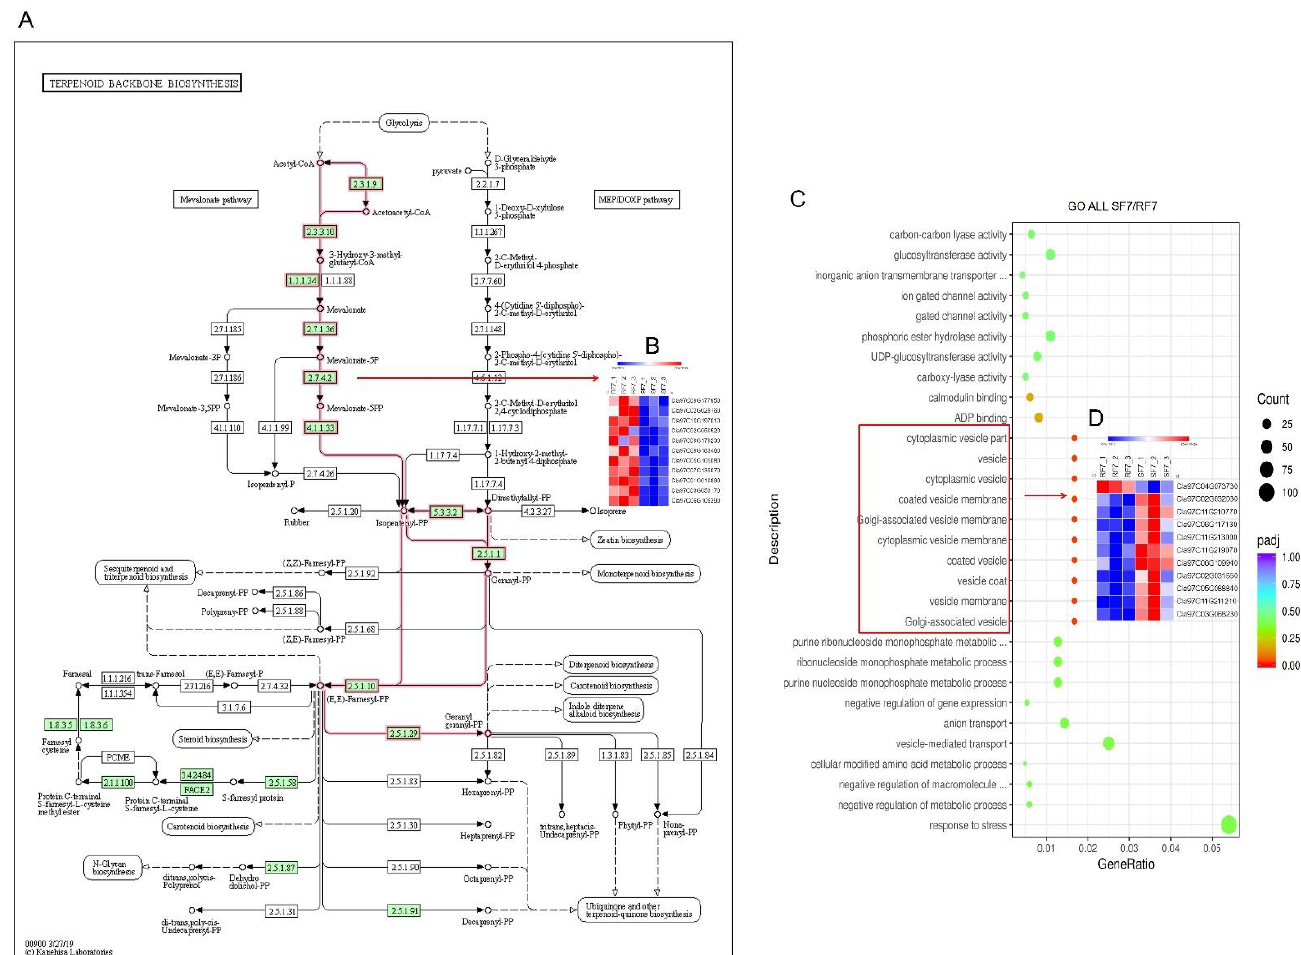
Figure 6. Function enrichment analysis of differential watermelon varieties: ( A ) Different expressed genes in Terpenoid backbone biosynthesis pathways; ( B ) Heatmap of 10 DEGs in Terpenoid backbone biosynthesis pathways; ( C ) All genes GO enrichment significant analysis; ( D ) Heatmap of 11 DEGs in GO enrichment analysis. Note: SF7, Susceptible cultivar +FON, 7 days post inoculation (7 dpi); RF7, Resistant cultivar+FON, 7 days post inoculation (7 dpi). Three independent replicates. Blue bands indicate low gene expression and red bands high gene expression.